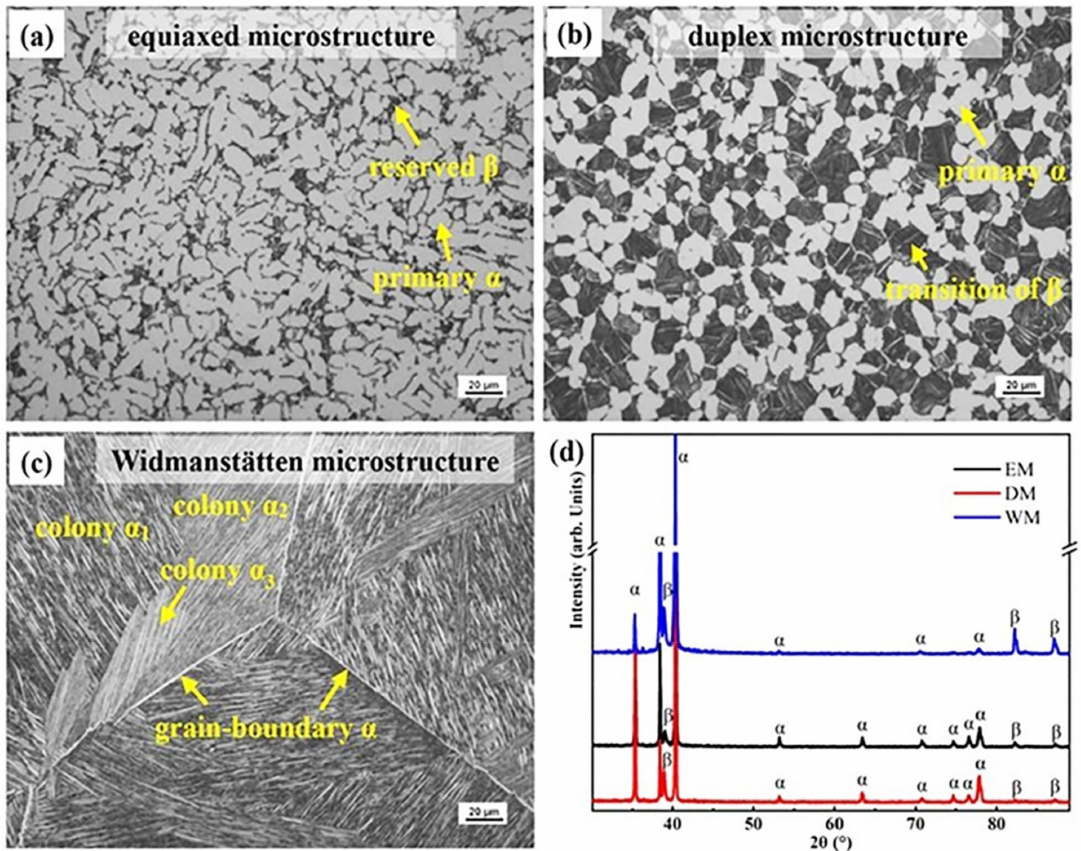
Figure 2. The microstructure of the Ti-6321 alloy by heat treatments at different temperatures: ( a ) 800 ◦ C; ( b ) 960 ◦ C; ( c ) 1020 ◦ C; ( d ) the corresponding XRD